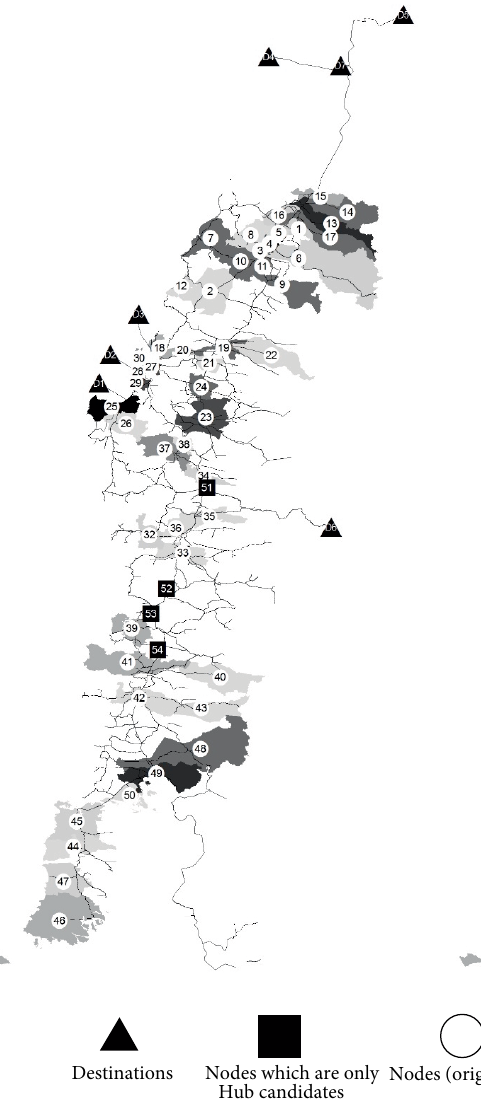
Table 1: Vector of variables 𝑌